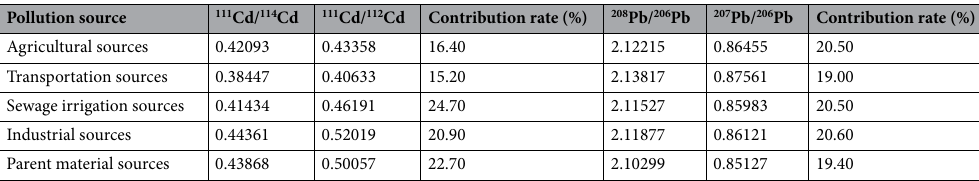
Table 5. Contribution rates of different sources base on average isotope ratios of Cd and Pb.